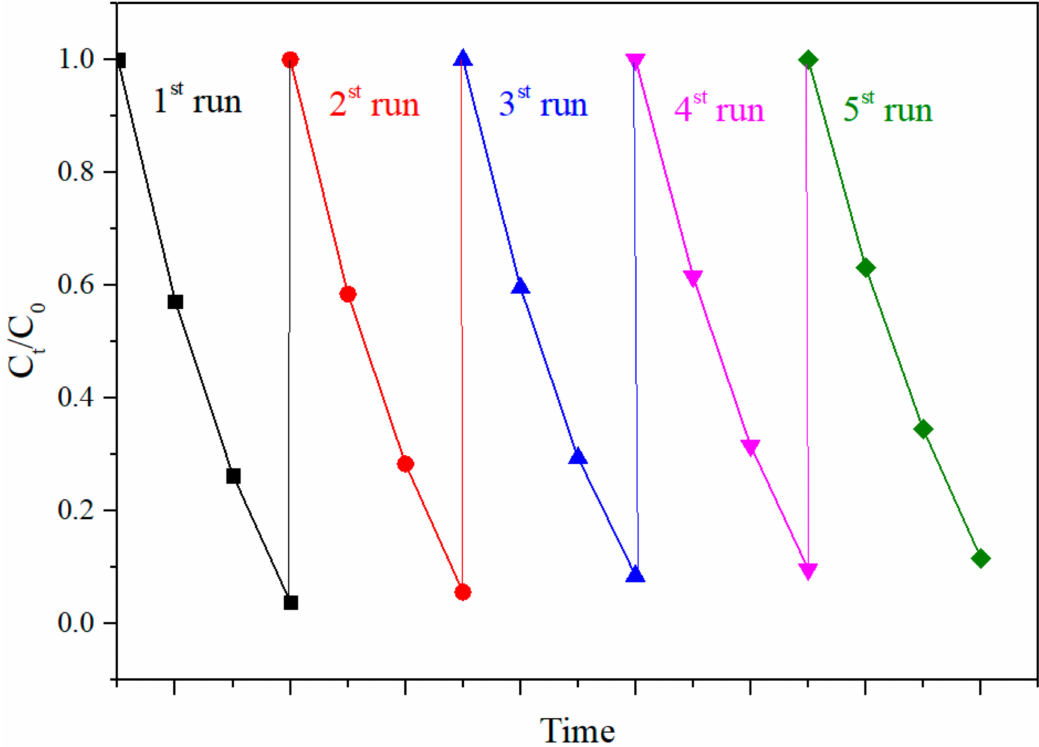
Figure 9. Cycling degradation test of RhB on BT-T